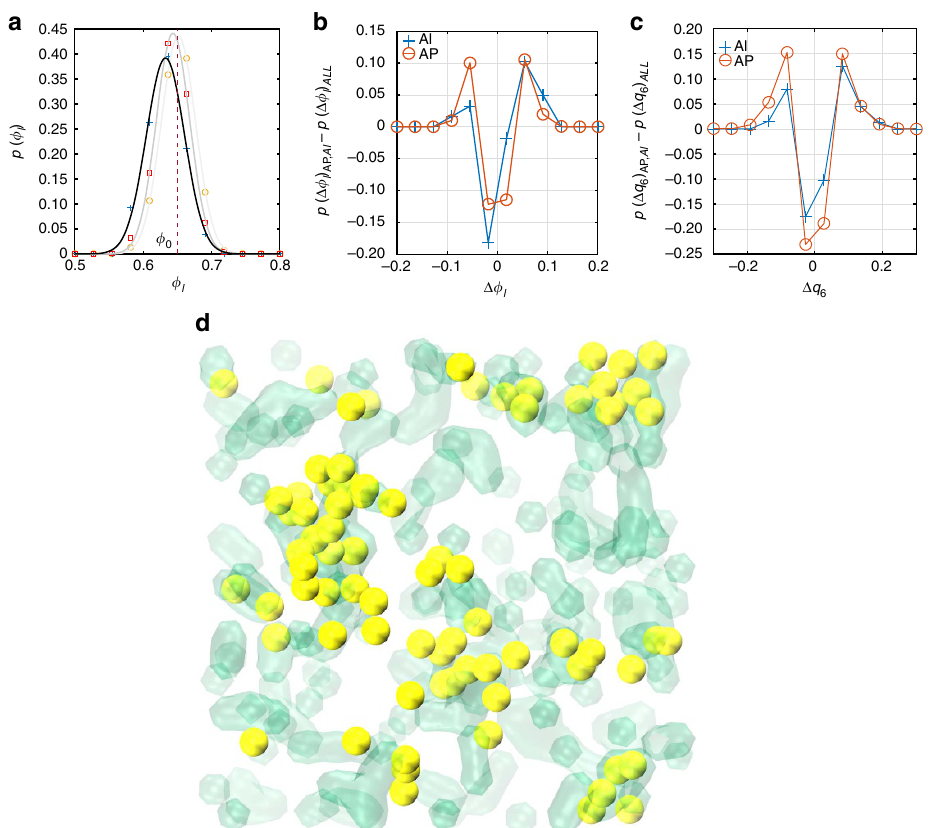
Figure 3 | Correlation between D / l and D q 6 . Distribution of D f l and D q 6 for AIs for ( a ) Devitrification, ( b ) Ageing. There is a clear positive correlation between translational and orientational order at this depth of overcompression ( f ¼ 0.65).